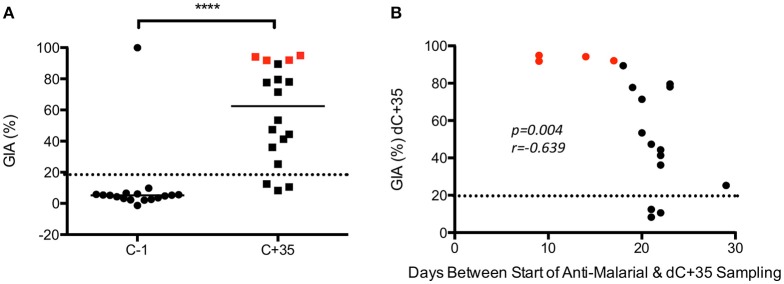
VAC049 GIA data. (A) Pre- and post–CHMI. Wilcoxon matched-pairs signed rank test. Individual data and median are shown. (B) Correlation between GIA at C+35 and days between start of anti-malarial therapy and sampling at C+35 visit. Spearman rank test. Volunteers not successfully infected are highlighted in red. GIA expected to be < 20% in malaria-naïve individuals (dotted line). C−1 = baseline pre-CHMI. C+35 = 35 days post-CHMI. ****p <0.0001.